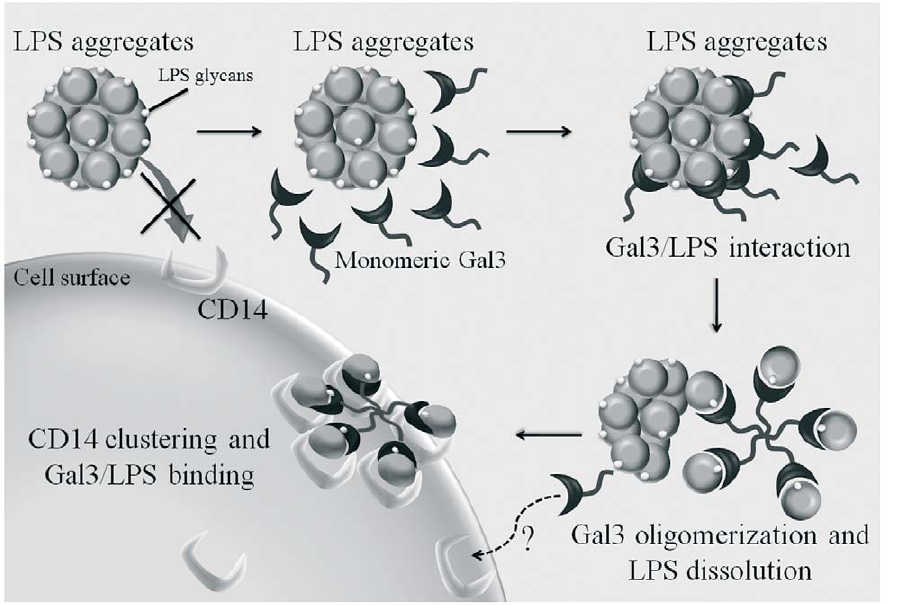
Figure 8. Schematic view of putative mechanisms responsible for galectin-3 enhancement of LPS-induced neutrophil activation. Monomeric Galectin-3 interacts with LPS glycans from LPS aggregates via its C-terminal domain. LPS/Gal 3 interactions induce Gal 3 oligomerization, which promotes the dissolution of LPS aggregates, stabilizes LPS monomers and enhances the LPS interaction with surface receptors, leading to increased neutrophil activation. CD14 only is shown as the initial LPS ligand on neutrophils, because it is highly glycosylated and could, potentially, interact directly with Gal 3. Moreover, being GPI-anchored, CD14 would be most easily clustered on the cell surface. However, this implies a secondary clustering of TLR/MD2, which would transmit or modulate signals into the